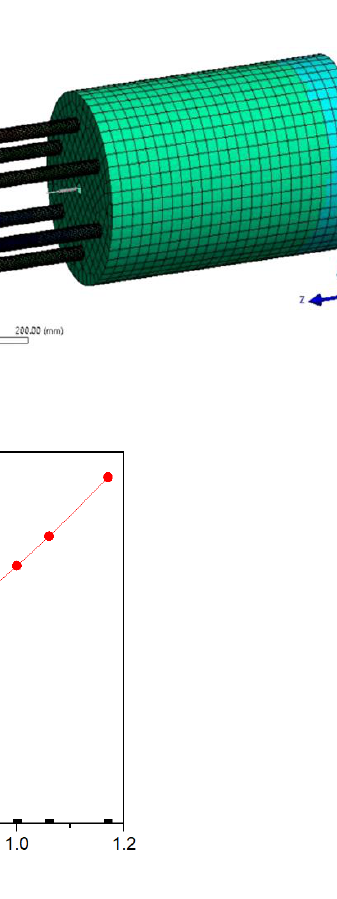
Figure 13. The X (transverse) displacement.